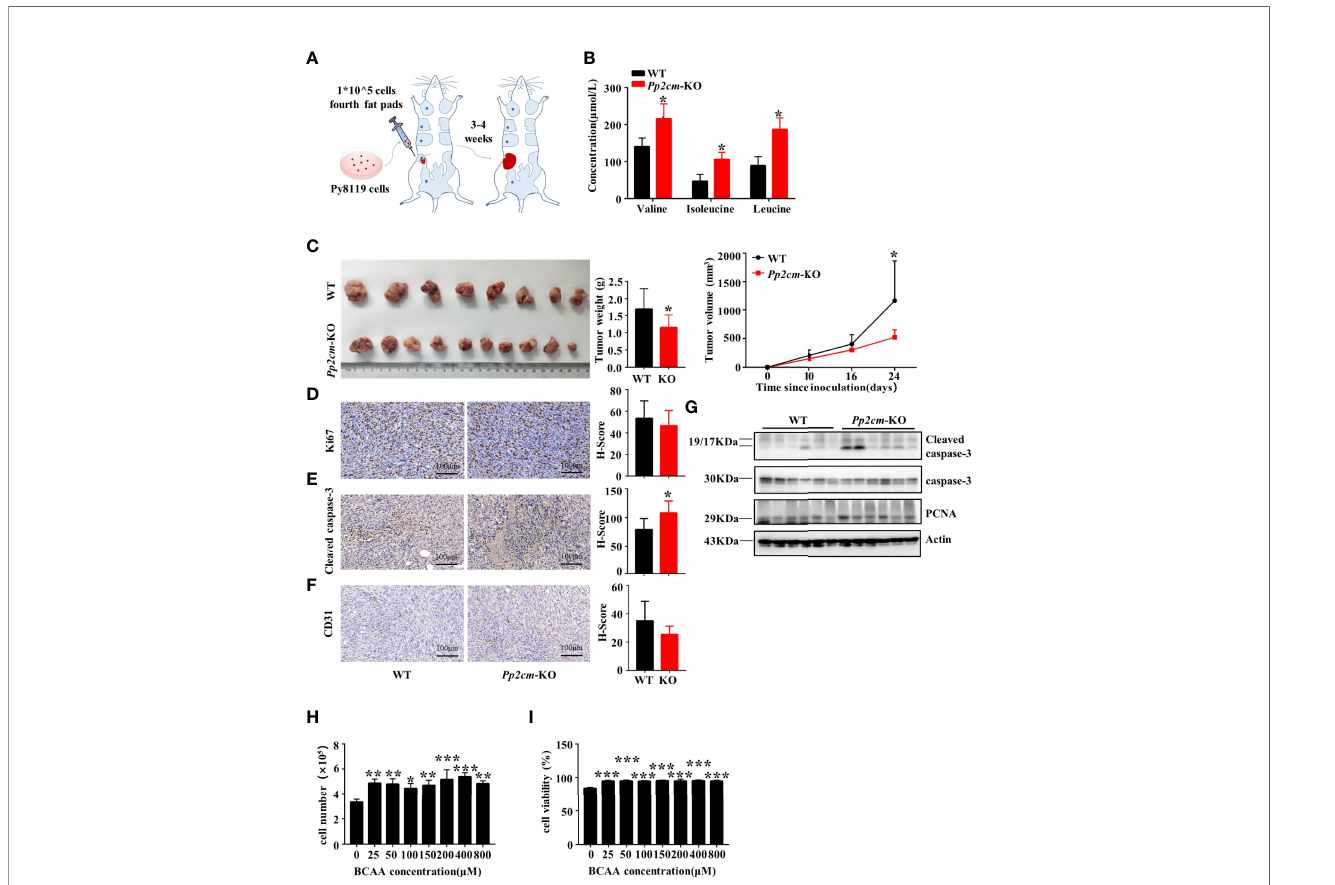
FIGURE 2 | Elevated BCAA inhibits orthotopic tumor growth of breast cancer. (A) The orthotopic allograft model. (B) The serum BCAA concentration of tumor- bearing mice after 6 hours of fasting. Mean ± SD, *p < 0.05, Student ’ s t-test. (C) The tumor-bearing Pp2cm -WT/KO mice were euthanized at 21days and tumor were harvested ( Pp2cm -WT, n =8; Pp2cm -KO, n =10). Tumor weight was measured at the end of the experiment and tumor volume was calculated using the following formula: tumor volume (cubic millimeters (mm 3 )) = 0.5× (length×width 2 ). Mean ± SD, *p < 0.05, Student ’ s t-test. (D) Proliferation marker Ki67, (E) apoptosis marker Cleaved caspase-3, and (F) angiogenesis marker CD31 expression was analyzed by immunohistochemistry. Mean ± SD, *p < 0.05, Student ’ s t-test. (G) Western blot was used to analyze the protein expression of Cleaved caspase-3, caspase-3 and PCNA (n=6 in each group). (H-I) Py8119 cell number and viability assay using Trypan blue exclusion test after treatment with different concentrations of BCAA for 48 hours. Cell viability was calculated as the number of viable cells divided by the total number of cells. The BCAA gradient medium was prepared with 8000 m M BCAA storage solution and custom BCAA-free DMEM. The